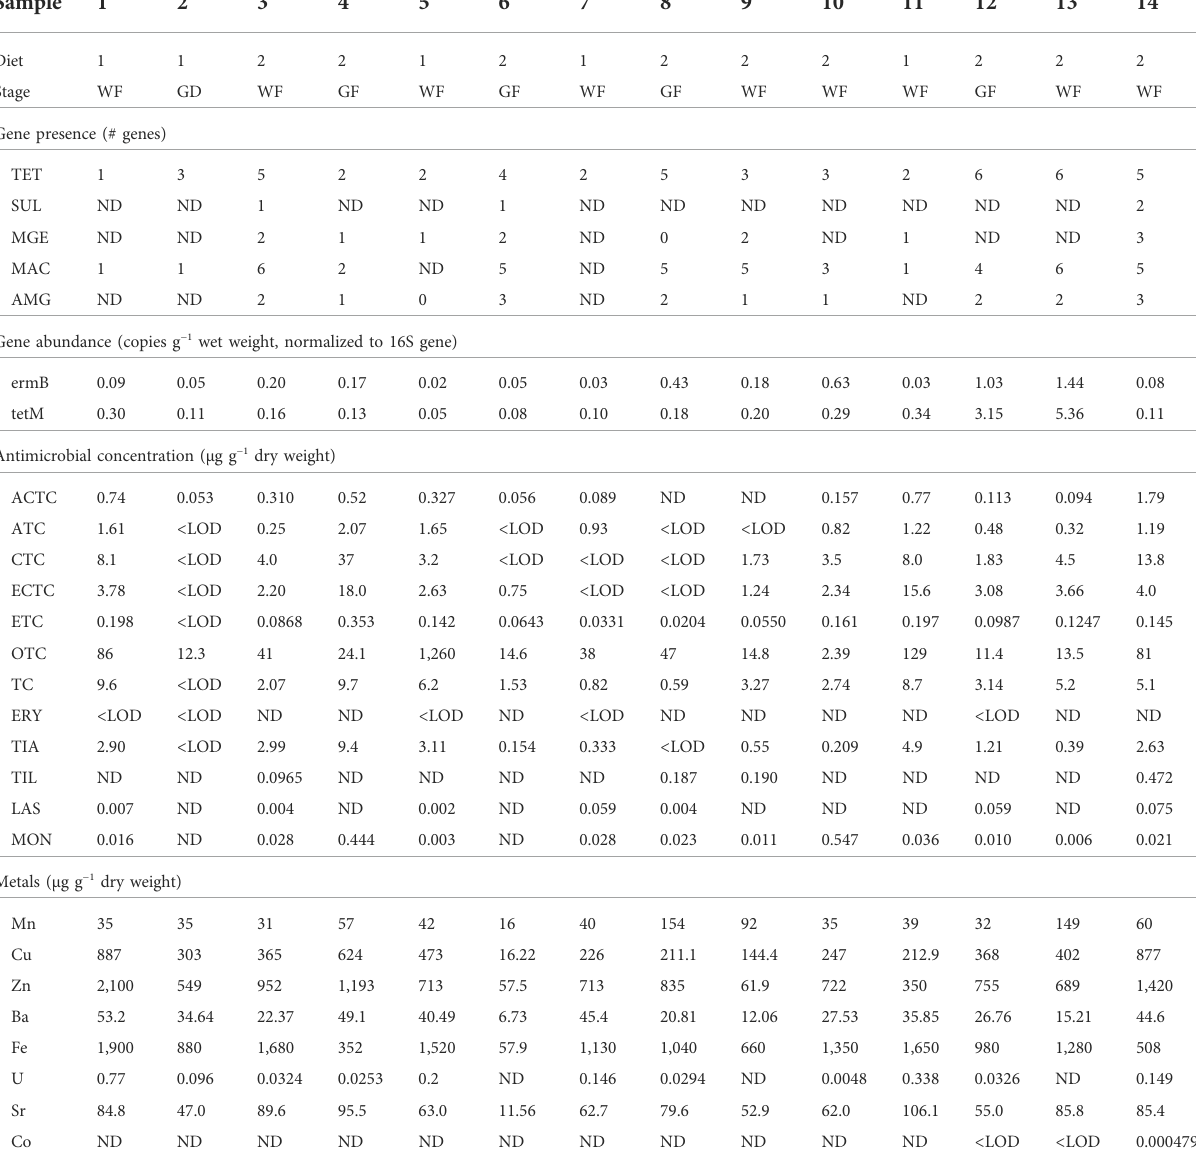
TABLE 2 Levels of antimicrobial resistance genes, antimicrobials, and metals detected in swine manure samples from manure lagoons at 14 swine farms in Iowa. Sample